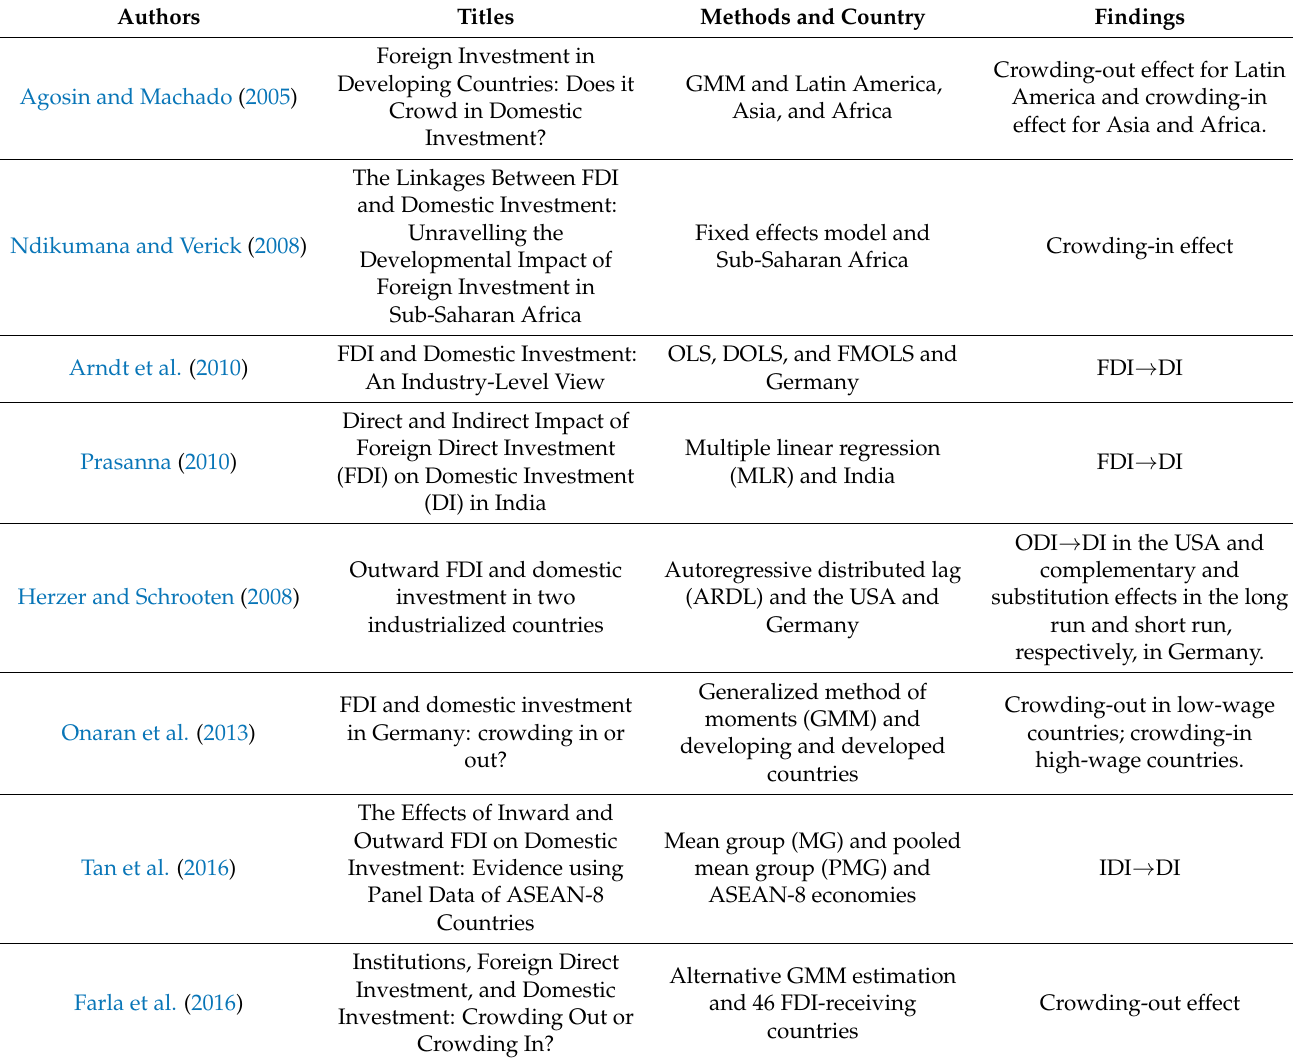
Table 1. Summary of the existing